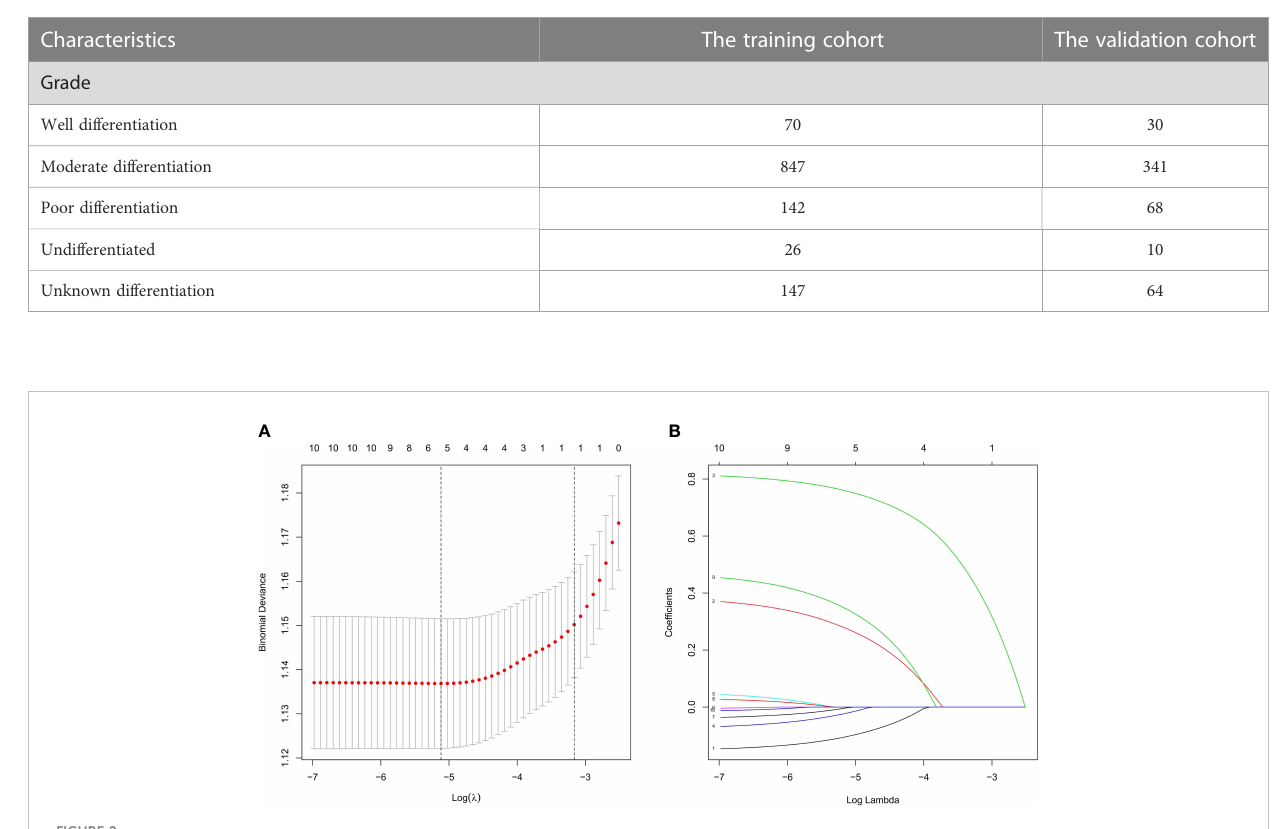
FIGURE 2 Feature selection using LASSO logistic regression. (A) Tuning parameter (l) selection in the LASSO logistic regression used 10-fold cross-validation via minimum criteria. The binomial deviance was plotted versus log ( l ). The black vertical lines were plotted at the optimal l based on the minimum criteria and l standard error of the minimum criteria. (B) LASSO coef fi cient pro fi les of the 10 clinical factors. A coef fi cient pro fi le plot was produced versus the log ( l ).